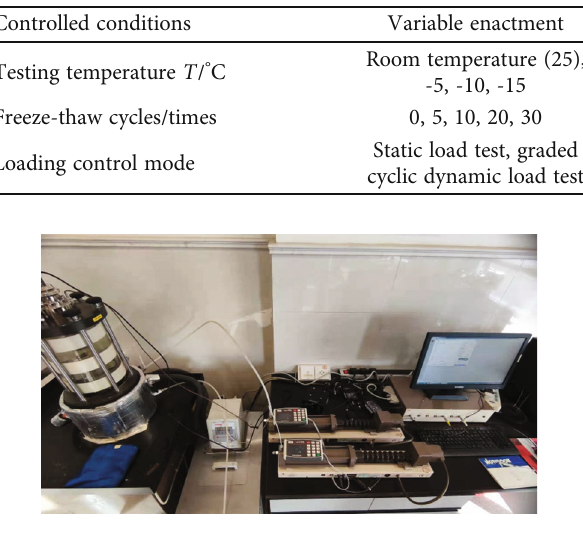
Figure 2: Triaxial test